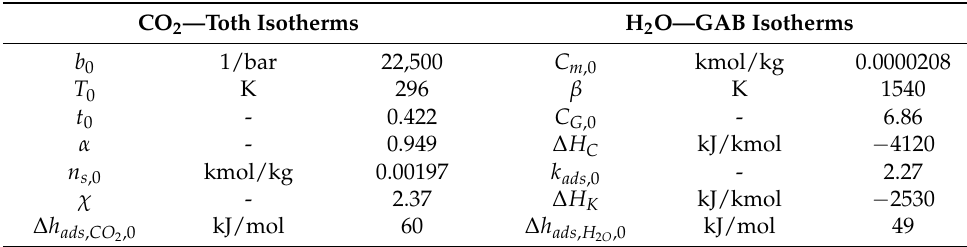
Table 1. Material properties